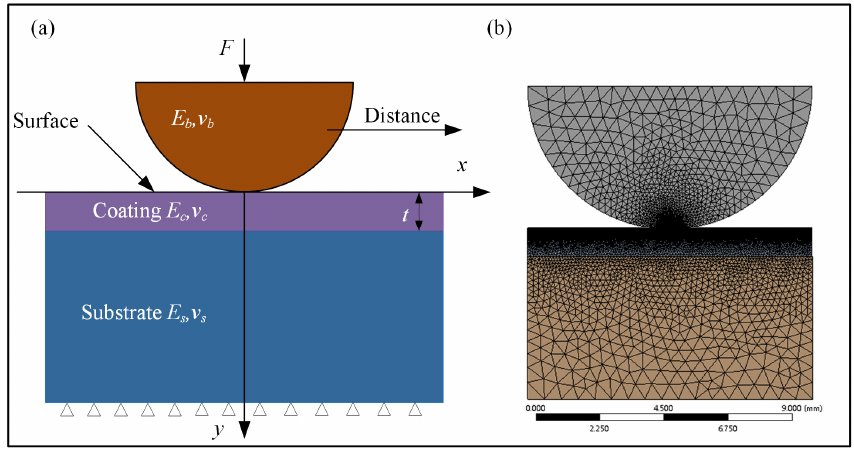
Figure 9. Finite element model of the ball-on-disk contact: ( a ) geometric model; ( b ) meshing model. Table 4. Mechanical parameters of the materials.